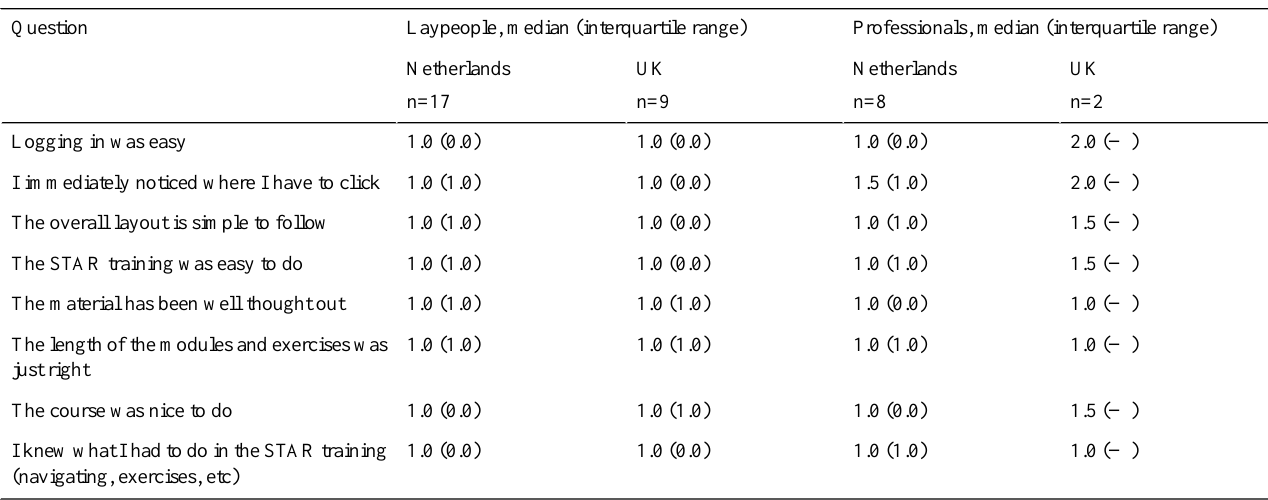
Table 4. Opinions on user friendliness (range 1-5).